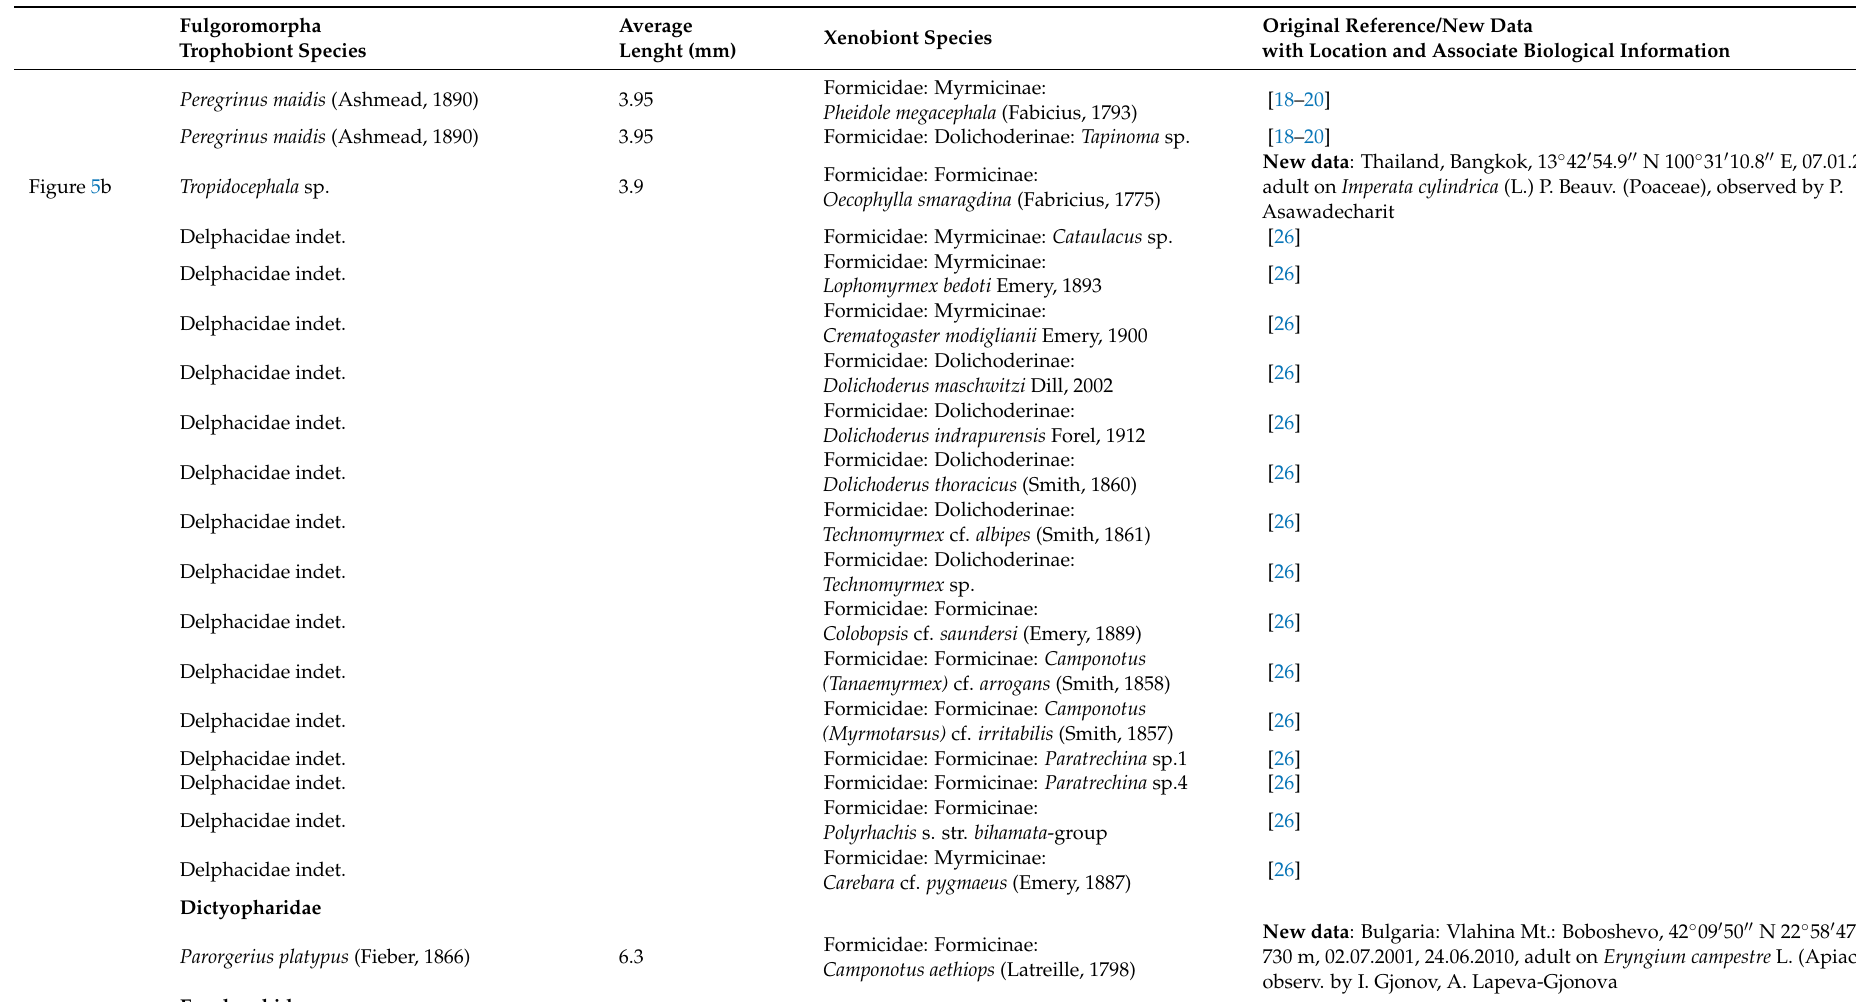
Formicidae: Dolichoderinae: Tapinoma sp. New data : Thailand, Bangkok, 13 ◦ 42 (cid:48) 54.9 (cid:48)(cid:48) N 100 ◦ 31 (cid:48) 10.8 (cid:48)(cid:48) E, 07.01.2021, Formicidae: Formicinae: adult on Imperata cylindrica (L.) P. Beauv. (Poaceae), observed by P. Oecophylla smaragdina (Fabricius, 1775) Asawadecharit